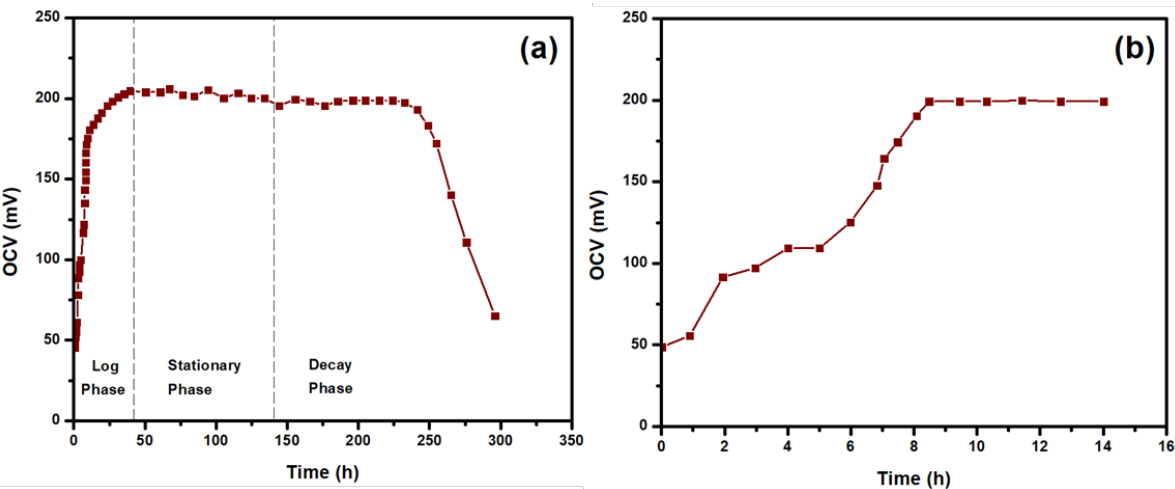
Figure 2. ( a ) Open circuit voltage curve with time for M. chroococcus ; ( b ) larger representation of the log phase.